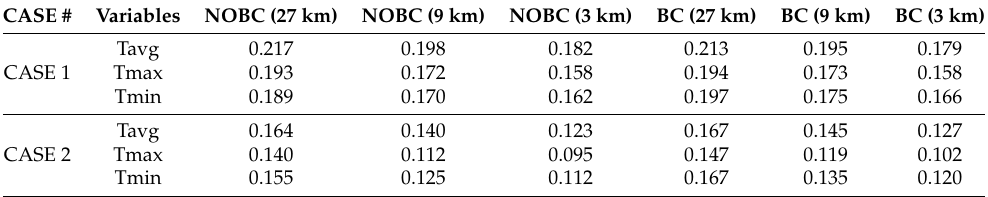
Table 2. Averaged normalized RMSE ( ◦ C) for 94